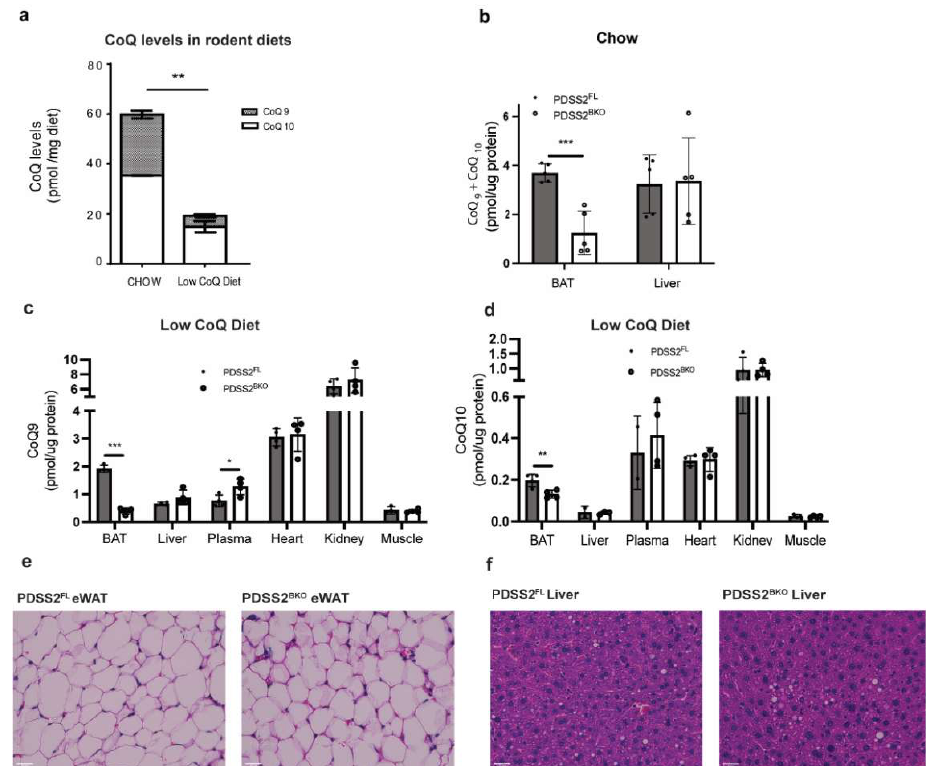
Figure A2. ( a ) Levels of CoQ9 and CoQ10 were lower in a low CoQ diet compared to a normal chow diet. ( b ) Combined CoQ 9 and CoQ 10 measurements in BAT and liver of PDSS2 BKO and PDSS2 FL mice fed a normal chow diet, n = 5. CoQ levels in BAT of PDSS2 BKO are decreased to 50% of PDSS2 FL and unchanged in the liver. ( c,d ) Individual CoQ 9 and CoQ 10 measurements in tissues of PDSS2 BKO and PDSS2 FL mice fed a defined low CoQ diet, n = 4. H&E staining of ( e ) eWAT and (f) liver of PDSS2 FL and PDSS2 BKO animals show no notable morphological differences. Data represent mean ± SEM. Significance presented at * p < 0.05, ** p < 0.01, and *** p < 0.001 compared to controls or otherwise indicated.